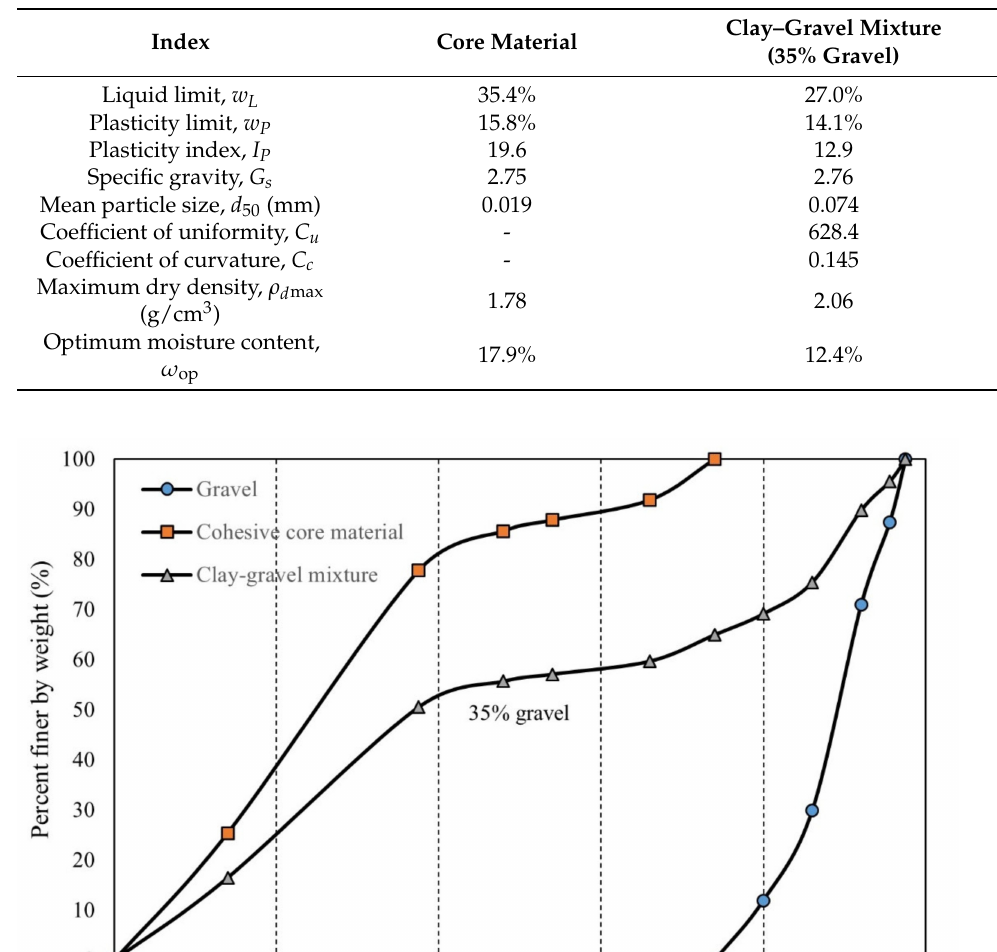
Table 2. Index properties of base core material and clay–gravel mixture.